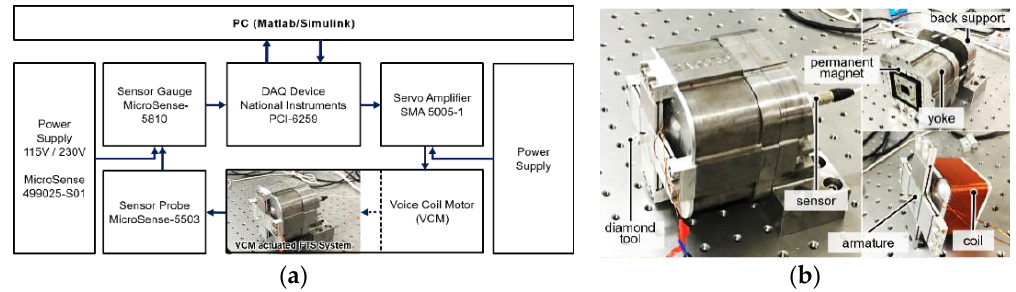
Figure 8. Experimental setup, ( a ) schematic of the testing system and ( b ) the photography of the prototype.